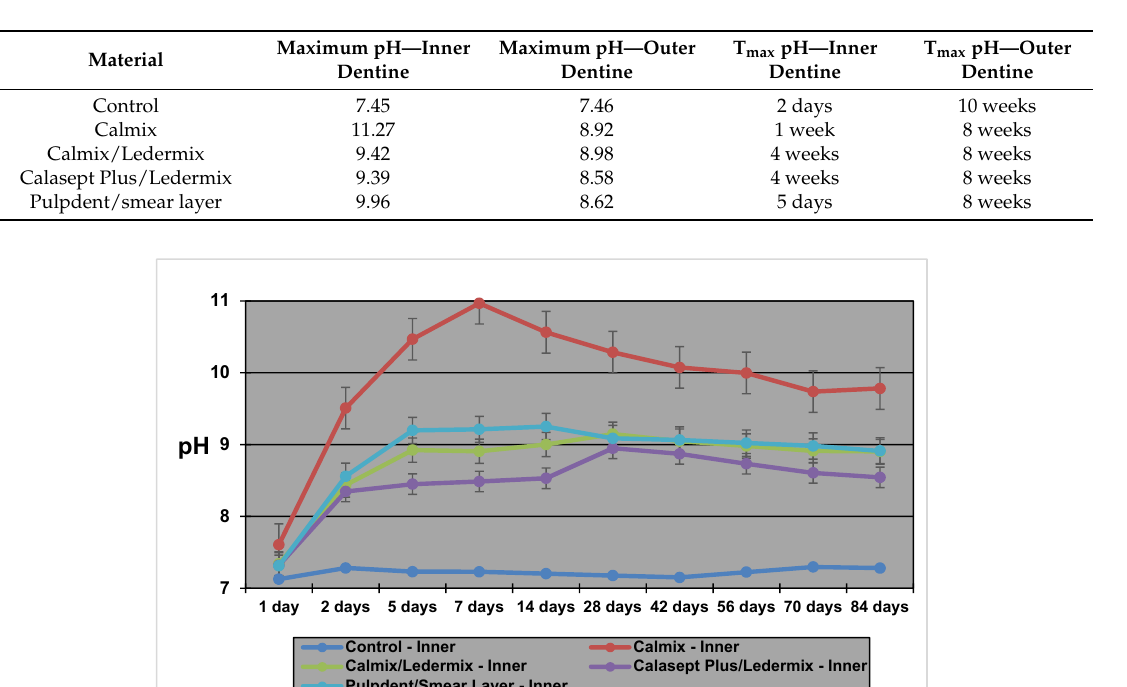
Figure 1. The pH values in the inner dentine with the various medicaments over 12 weeks.